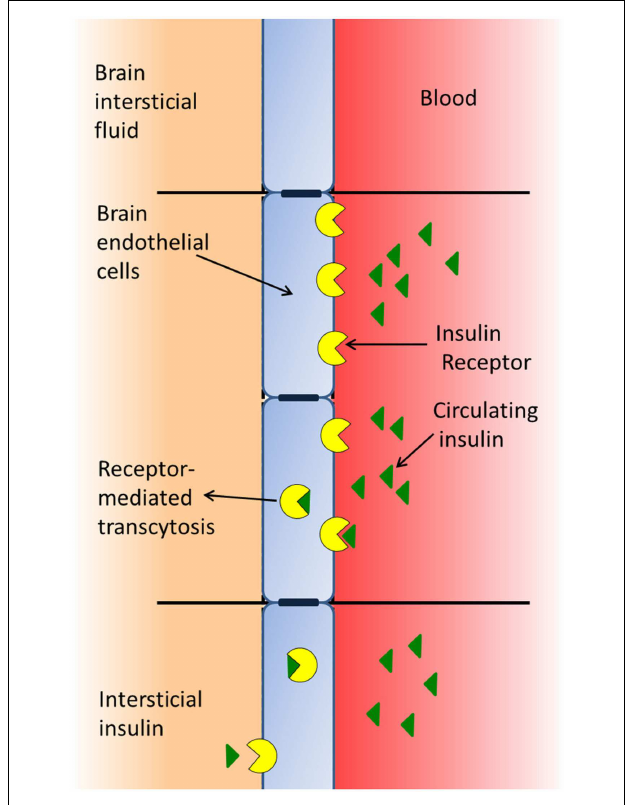
FIGURE 1 | Insulin of peripheral origin may pass through the blood–brain barrier using a receptor-mediated transport system